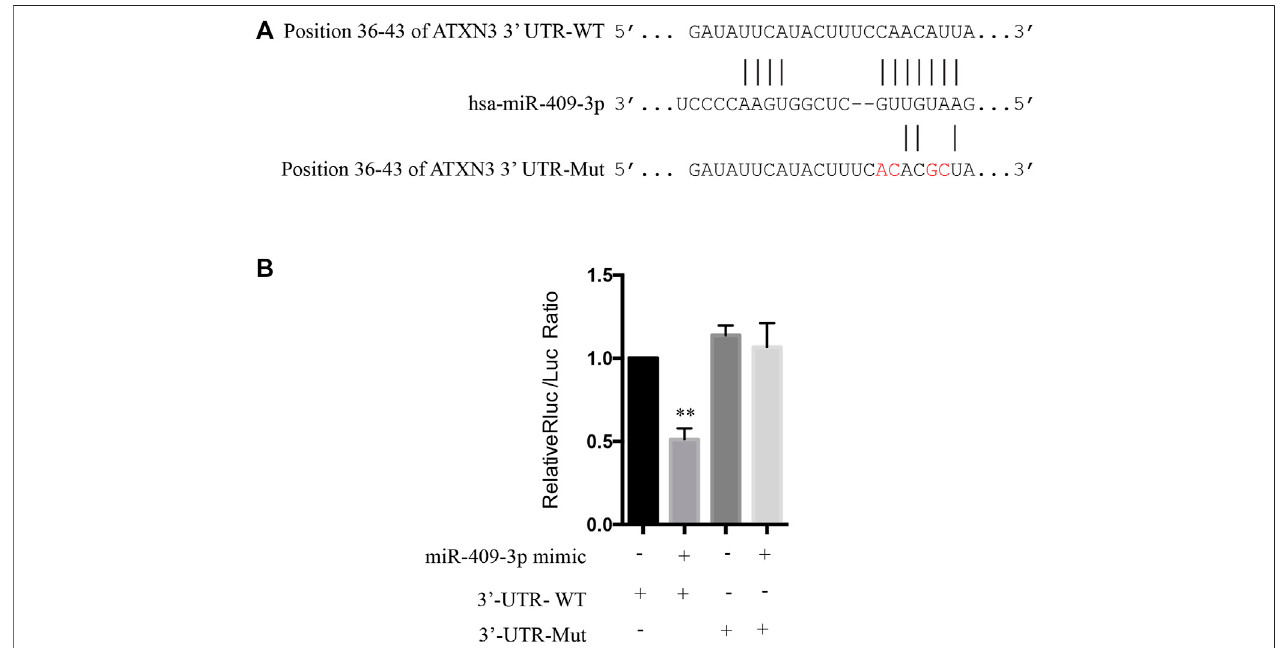
FIGURE 6 | The prediction in bioinformatics and dual luciferase reporter gene assay to determine the targeted relationship between miR-409-3p and ATXN3. (A) ThebindingsitesofmiR-409-3pandtheposition36-43ofATXN3 ’ UTR-WTandATXN3 ’ UTRMut(GTTGTAAGchangetoGTCCAAAG)predictedinthewebsite. (B) The relative luciferase activity of the cells co-transfected with miR-409-3p mimic and ATXN3-WT was signi fi cantly reduced. Data were analyzed using Student t -test, * p < 0.05; ** p < 0.01.